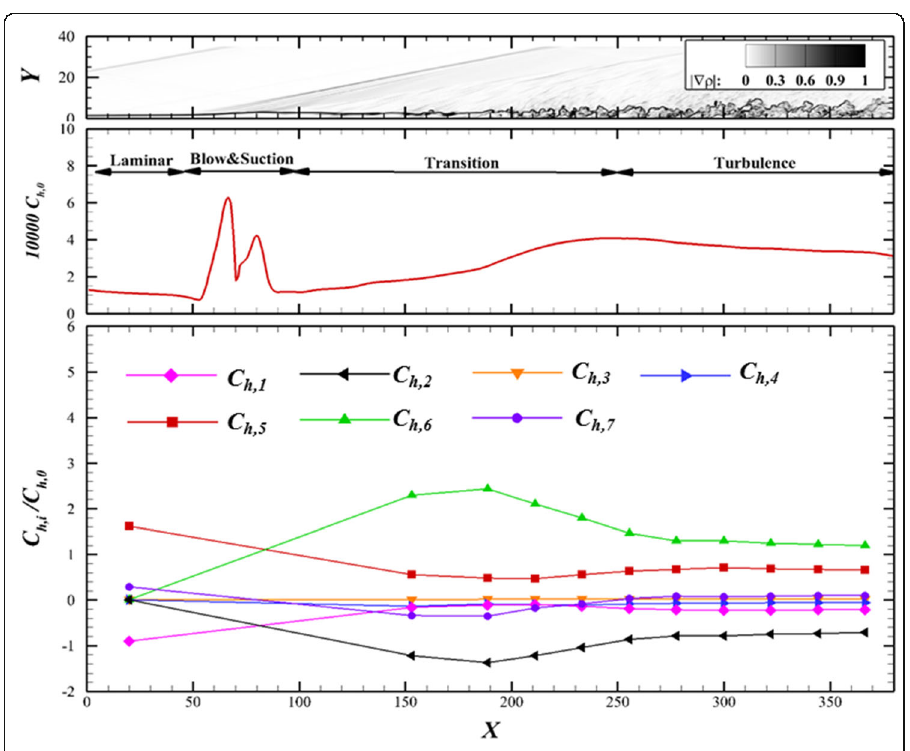
Fig. 5 The streamwise trends of the contributions of the terms of heat flux